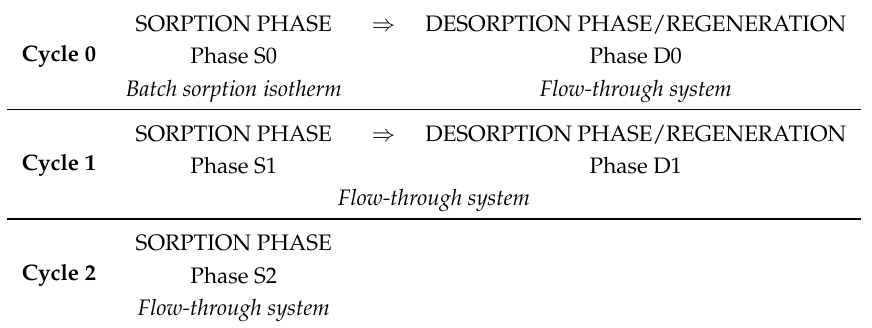
Table 3. Experimental sequence for sorption and desorption cycles for the regeneration of Al/Fe-rich P sorption materials (PSMs). The same cycles were tested at both low level (0.5 mg P L − 1 ) and high level (50 mg P L − 1 ) P treatments. All experiments were conducted in